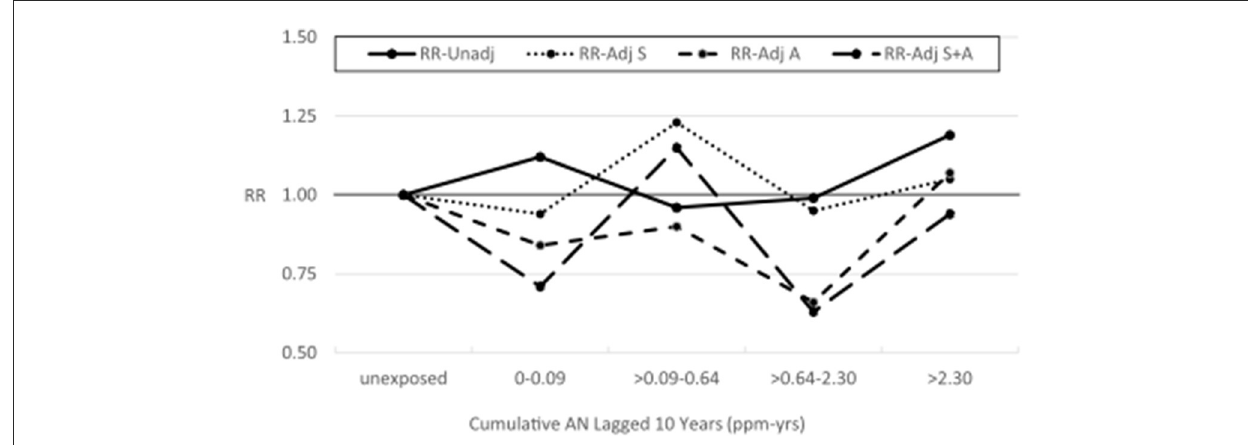
FIGURE3 Lung cancer relative risks by cumulative AN exposure, full cohort—unadjusted and adjusted for smoking using the Richardson method (Continuous Data).